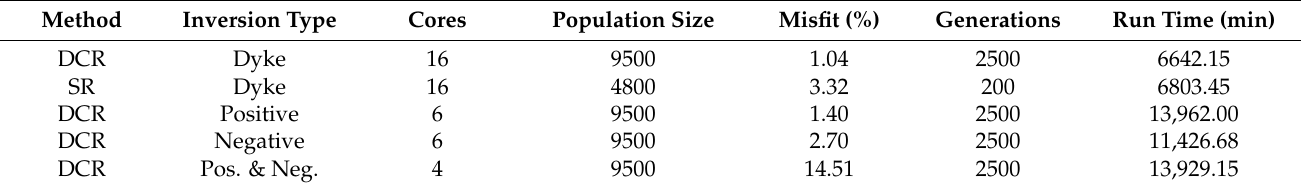
Table 5. Summary of the convectional global optimization inversion results parameter for both DCR and SR (dyke, positive, positive and negative anomalies model)